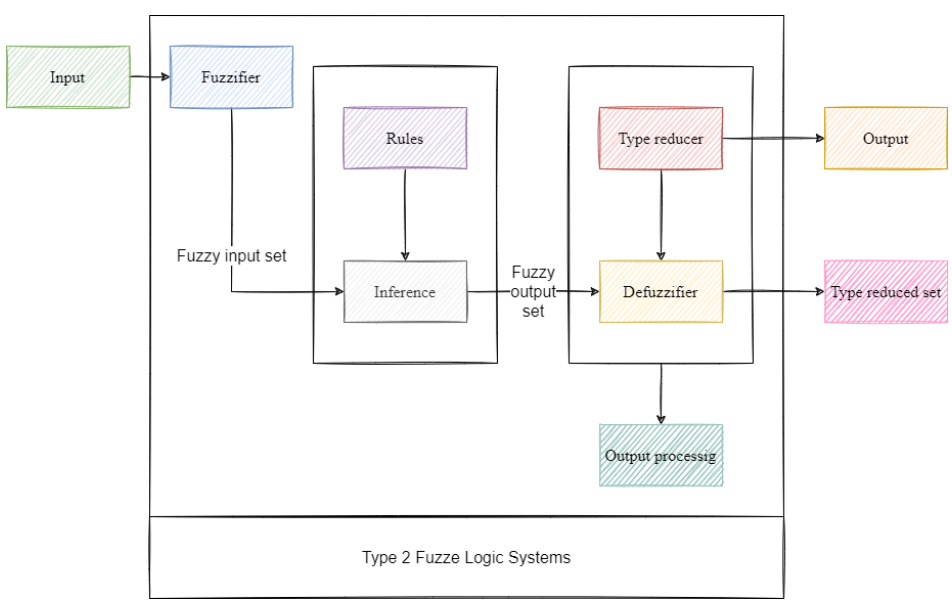
Figure 2. Type 2 fuzzy logic system.